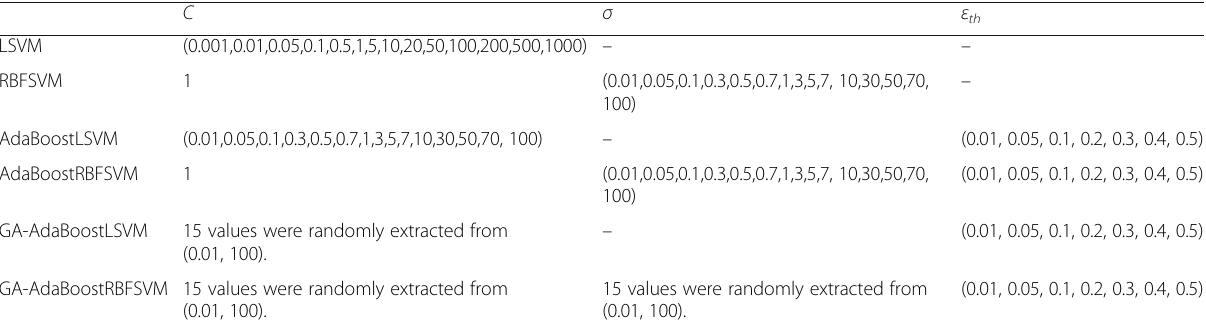
Table 8 Parameter